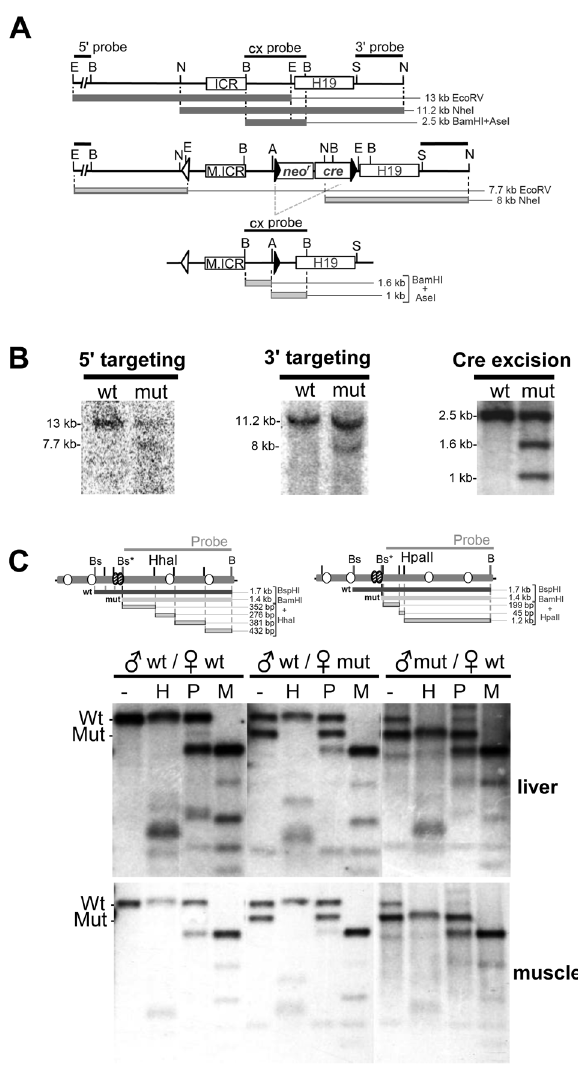
Figure 4. Octamer mutations increase maternal ICR methyla- tion in neonatal somatic tissues. (A) Restriction map for the H19/ Igf2 locus, targeting vector insertion and the targeted locus following excision of the selection cassette. The neomycin resistance ( neo r ) and Cre recombinase ( cre ) genes were removed in the germline of male chimeras by testes-specific expression of Cre. Restriction sites are Ase I (A), BamH I (B), Ecor V (E), Nde I (N), and Sal I (S). (B) Southern blot analysis to confirm targeting of the mutant ICR (M.ICR) was carried out on Ecor V or Nde I digested WT and targeted ES cell DNA hybridized to 5 9 and 3 9 probes, respectively. Correct Cre-mediated excision of the selection cassette was confirmed by BamH I and Ase I-digestion of tail DNA from F1 mice. (C) Methylation sensitive Southern blot analysis was performed on DNA from neonatal liver and muscle from WT and heterozygous mutant mice. Genomic DNA was digested with BamH I and BspH I (Bs) and then Hha I (H), Hpa II (P), or Msp I (M). Restriction maps of ICR are shown. The mutation in OctB created an additional BspH I (Bs*) restriction site. The 1.4 kb mutant ICR BspH I- BamH I fragment was used for the probe. The results shown are representative of methylation sensitive Southern analysis performed on six pups from four different mutant